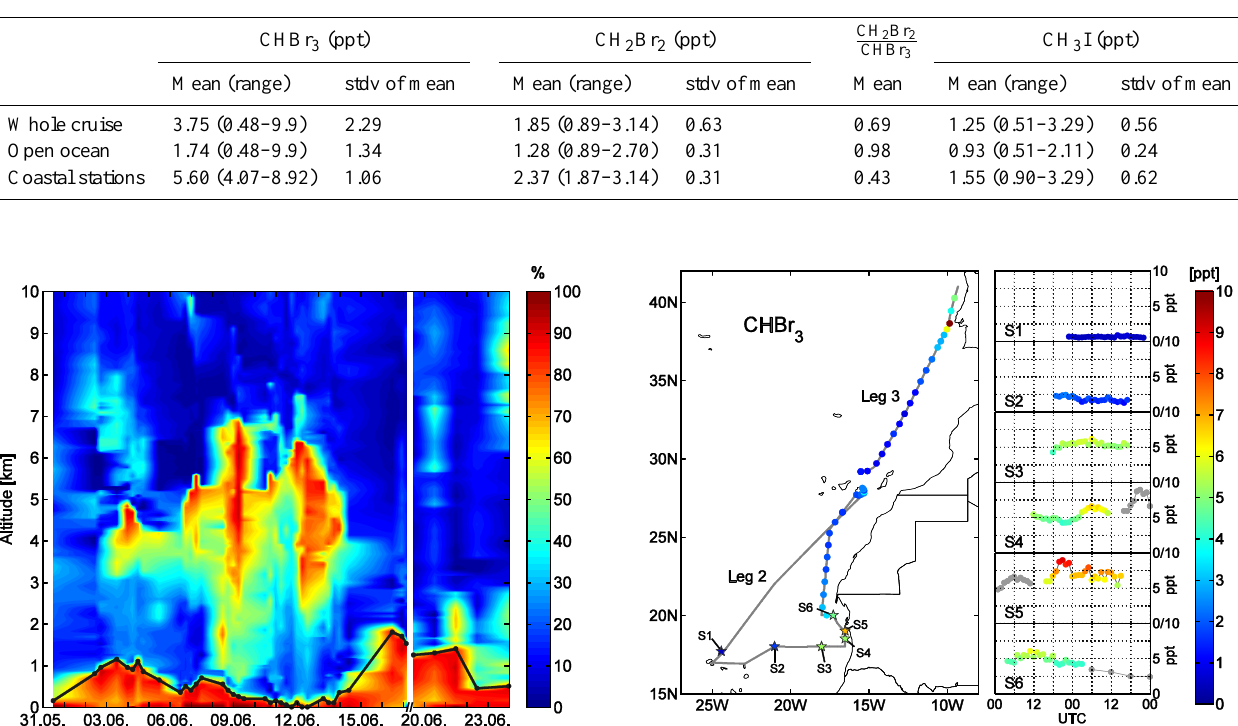
Table 2. Observed mixing ratios [inppt] of bromoform (CHBr 3 ), dibromomethane (CH 2 Br 2 ), their ratio and methyl iodide (CH 3 I) for the whole cruise, open ocean (leg 2 except stations 3–6, and leg 3) and coastal stations (stations 3–6). Given are the mean, the range and the standard deviation values.